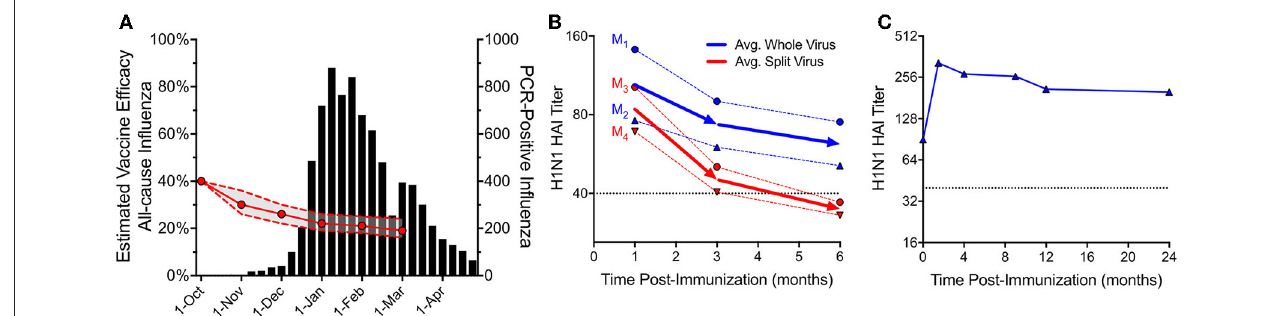
FIGURE 3 | Protective immunity after vaccination with repetitive (whole-virus) or non-repetitive (split-virus) influenza vaccines. Current inactivated influenza vaccines contain detergent-disrupted or “split” virus antigens and these formulations lose protective efficacy rapidly during the course of a single season. (A) A study of 7 influenza seasons involving 44,959 patients showed that the odds ratio (OR) for testing positive with influenza virus increased by ∼ 16% for each 28-day period after vaccination. If vaccine efficacy (VE) was 40% starting on October 1 st , we estimate that the subsequent decline in VE would result in only 20% VE during the peak of an average influenza season. The VE and associated 95% confidence intervals were inferred from the ORs in Table 2 (VE = [1 ÷ OR] × 40%) of Ray et al. (85). Data for total PCR-positive influenza tests from 2010/11 to 2016/17 seasons were adapted with permission from Figure 1 in Ray et al. (85). (B) In 1977, hemagglutination inhibition (HAI) responses to 2 commercial whole virus (WV) vaccines (dotted blue lines, M 1 , manufacturer 1; M 2 , manufacturer 2) and 2 split virus (SV) vaccines (dotted red lines, M 3 , manufacturer 3; M 4 , manufacturer 4) were monitored in parallel following a single immunization of adults ( n = 46-56/group) ( 86). HAI serum titers were adapted with permission from Figure 1 in Cate et al. ( 86) with the average of each group (WV or SV) shown as solid lines. (C) In 1953, a single dose of WV vaccine was administered to 45 young adults and HAI titers were monitored longitudinally for up to 2 years after vaccination ( 87). Antibody titers against the PR8 (A/H1N1) strain of influenza were adapted with permission from Figure 1 in Salk et al. (87). For panels (B) and (C) , the putative protective HAI antibody level of 1:40 is shown as a dotted